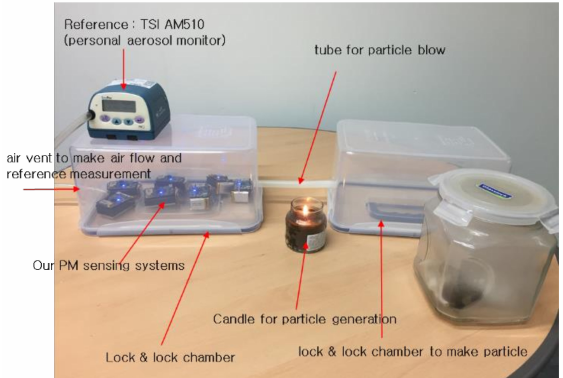
Figure 13. Experimental environment.